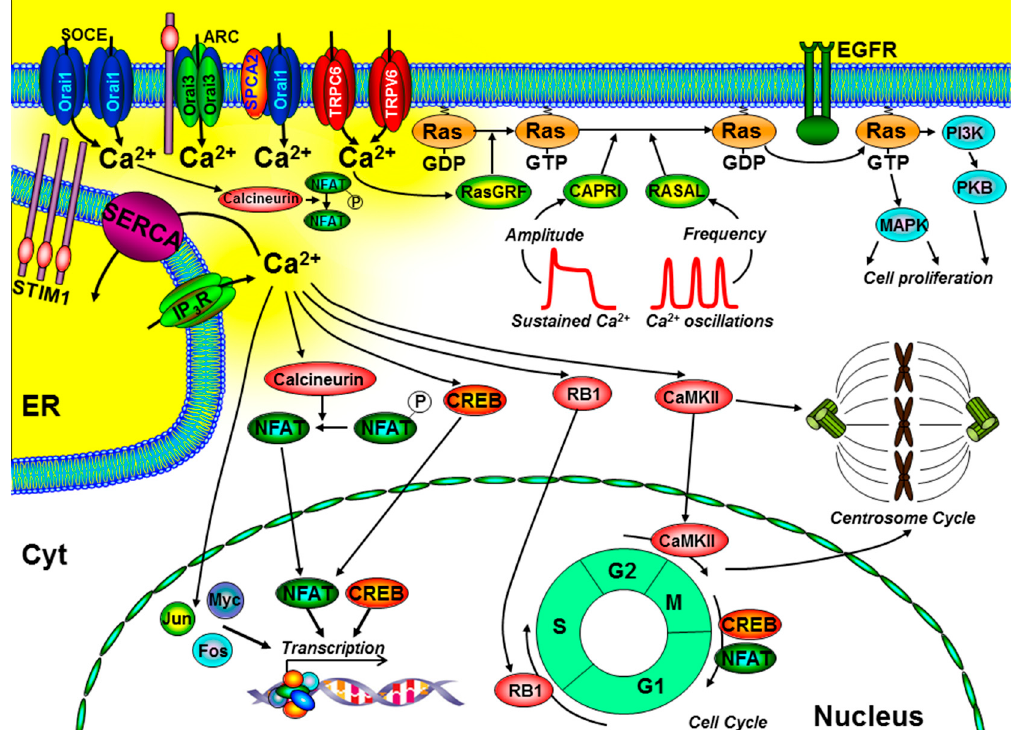
Figure 2. The role of key components of the Ca 2+ signalling machinery in the control of cell proliferation and the cell cycle. Ca 2+ entry through store-operated Ca 2+ channels (SOCE; consisting of endoplasmic reticulum (ER) stromal interacting molecule (STIM)1 and Orai1), arachidonate-regulated Ca 2+ channels (ARC; consisting of plasma membrane STIM1 and Orai1/Orai3 heteropentamers), transient receptor potential channel (TRPC)6, TRPV6, and the non-SOCE (plasma membrane secretory pathway ATPase (SPCA)-regulated Orai1) have all been implicated to regulate cell proliferation. Specific spatiotemporal patterns of Ca 2+ signals can differentially regulate gene transcription (via calcineurin/nuclear factor of activated T cells (NFAT), CAMKII/cAMP response element-binding protein (CREB), immediate early genes (Jun, Myc, and Fos)), and the Ras/ERK signalling pathway. Localised Ca 2+ entry can specifically activate the Ras guanine exchange factor (Ras-GEF), Ras-GRF, which converts the inactive Ras-guanosine diphoshpate (Ras-GDP) to the activate Ras-guanosine triphoshpate (Ras-GTP). Moreover, the amplitude of Ca 2+ signals can specifically activate CAPRI and the frequency of Ca 2+ oscillations can specifically activate RASAL, both of which are Ras guanine activating proteins (Ras-GAPs) that inactivate Ras-GTP. Ca 2+ also has an important role in the control of the cell cycle and centrosome cycle. Specifically, Ca 2+ -dependent activation of retinoblastoma-1 (RB1) regulates G1/S phase transition, CaMKII regulates G2/M phase transition, and CREB and NFAT can regulate M/G1 transition. Additional abbreviations include EGFR, epidermal growth factor receptor; PI3K, phosphinositide-3 kinase; PKB, protein kinase-B; MAPK, mitogen-activated kinase; cell cycle phases: G1 and G2, gap; S, synthesis; M, mitosis.